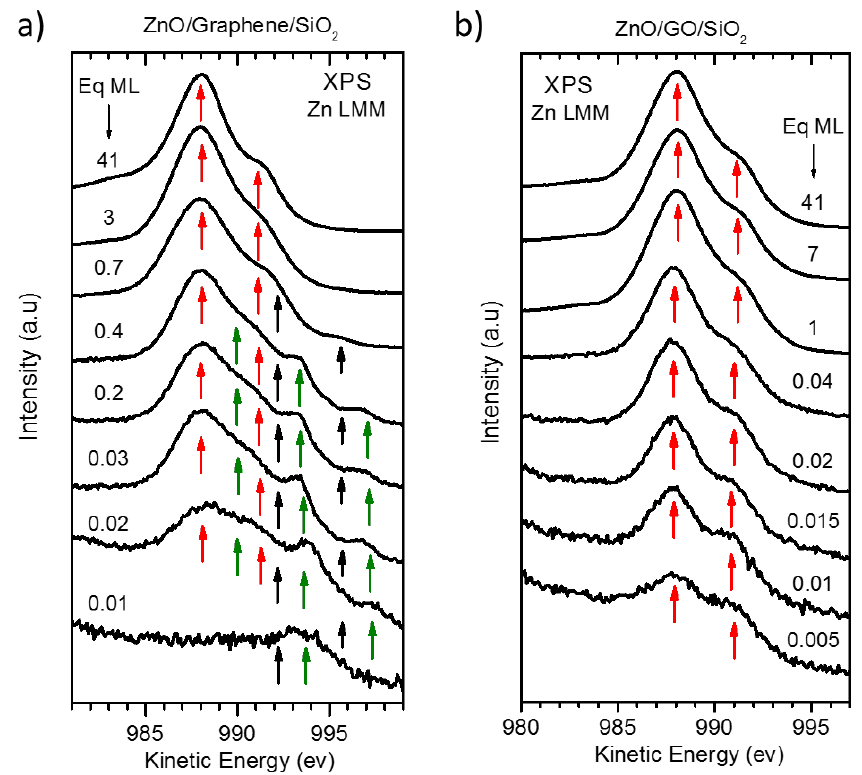
Figure 7. Auger Zn-LMM XPS spectra as a function of the coverage for the growth of: ( a ) ZnO / G / SiO 2 and ( b ) ZnO / GO / SiO 2 . Energy positions of the main Auger peaks for ZnO (red arrows), metallic Zn (black arrows) and ZnO x (green arrows) are indicated.